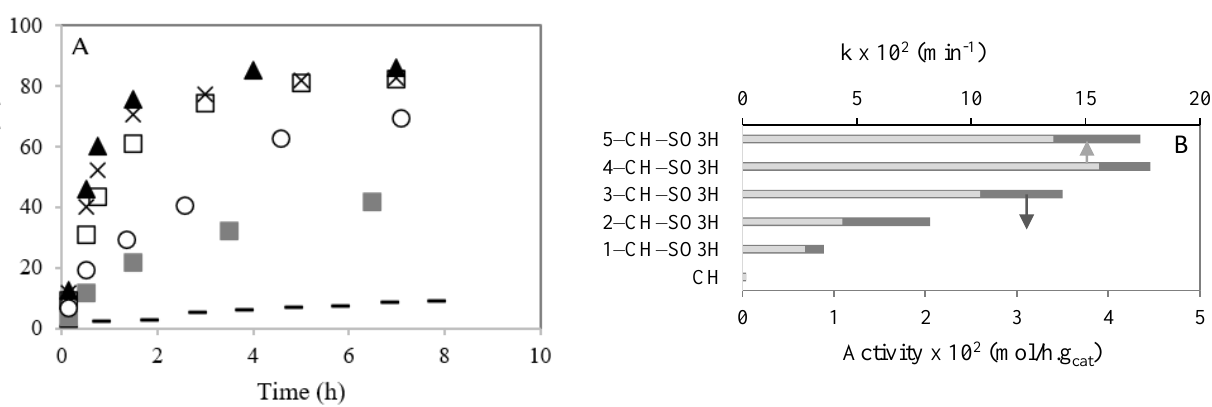
Figure 5. Esterification of caprylic acid with methanol in the presence of chitosan with SO 3 H, at 60 °C: ( A ) conversion (%) versus time (h). (–) CH; ( ) 1–CH–SO 3 H; ( ) 2-CH–SO 3 H; ( ) 3–CH–H; ( ) 4–CH–SO 3 H; (×) 5–CH–SO 3 H; ( B ) initial activ- ities taken as the maximum observed reaction rate and k (min −1 ). Reaction conditions: catalyst amount (0.2 g); temperature (60 °C), molar ratio caprylic acid to methanol (1:95).